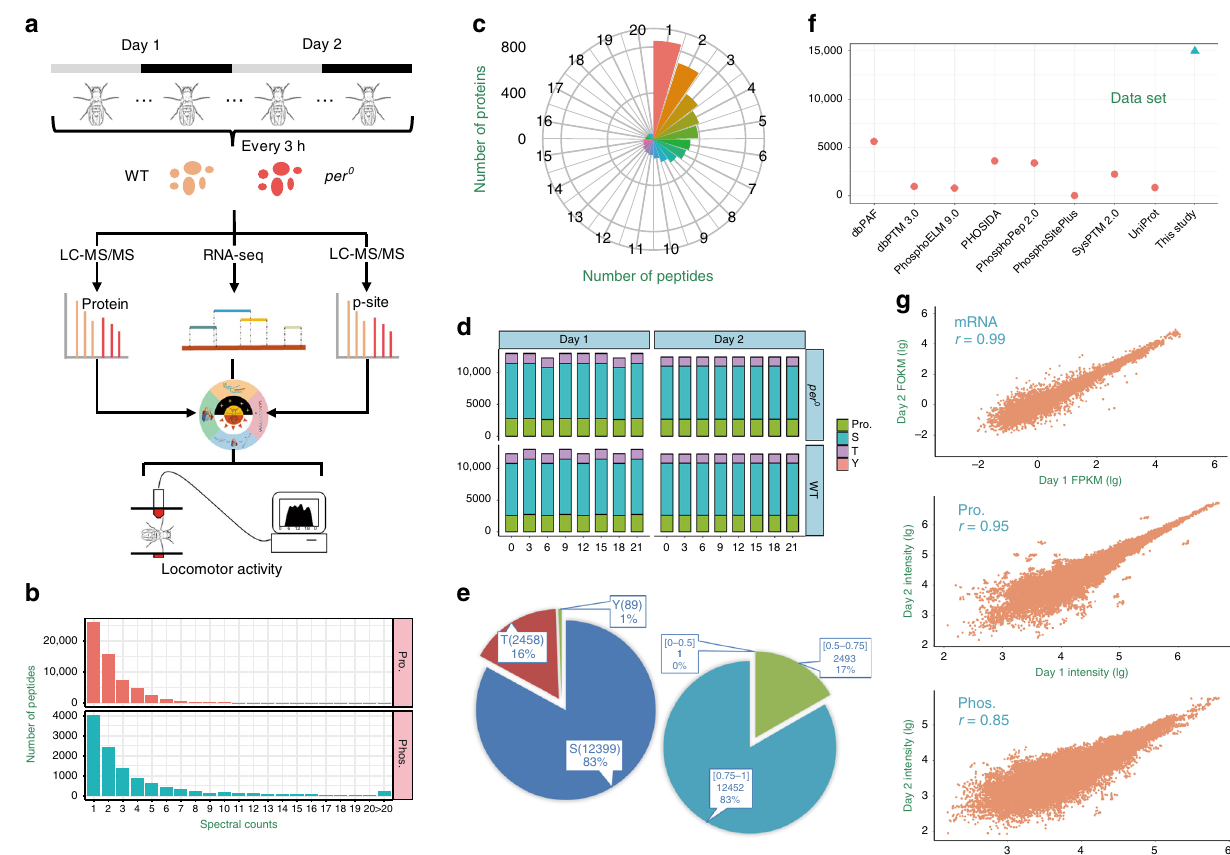
Fig. 1 Circadian multi-omics pro fi ling of fl y heads. a WT and per 0 fl y heads were collected at 3 h intervals on 2 days in DD. LC-MS/MS-based proteomics and phosphoproteomics as well as RNA-seq-based transcriptomics were conducted. An integrative pipeline iCMod was implemented for analyzing the multi-omics data. NCPs were detected and their corresponding protein kinases were predicted. Locomotor rhythm analysis was employed for validation of the predicted kinases. b The distributions of raw MS/MS spectral counts of peptides and phosphopeptides quanti fi ed from proteomics and phosphoproteomics data, respectively. c The distribution of peptide numbers quanti fi ed from proteomics data. d The number of phosphoproteins, as well as p-Ser, p-Thr, and p-Tyr residues identi fi ed in each sample. e The distribution of the amino-acid residues (left) and the assigned localization probability (right) for all detected p-sites. f Comparison of p-sites detected in this study with known p-sites curated in public databases. g The Spearman ’ s rank correlations of transcriptomes, proteomes, and phosphoproteomes detected on Day 1 and Day 2,